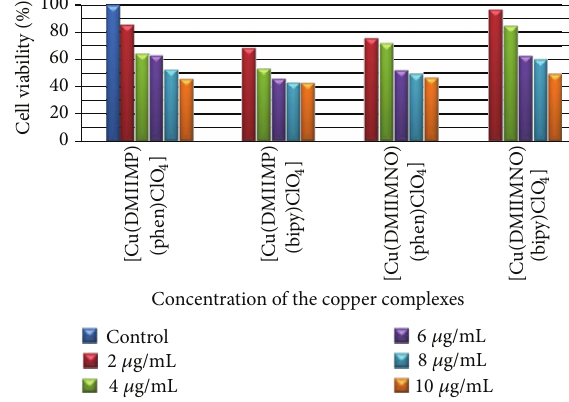
Figure 5: Percentage of cell viability versus different concentrations for HeLa cells exposed to the metal complexes after 72 h